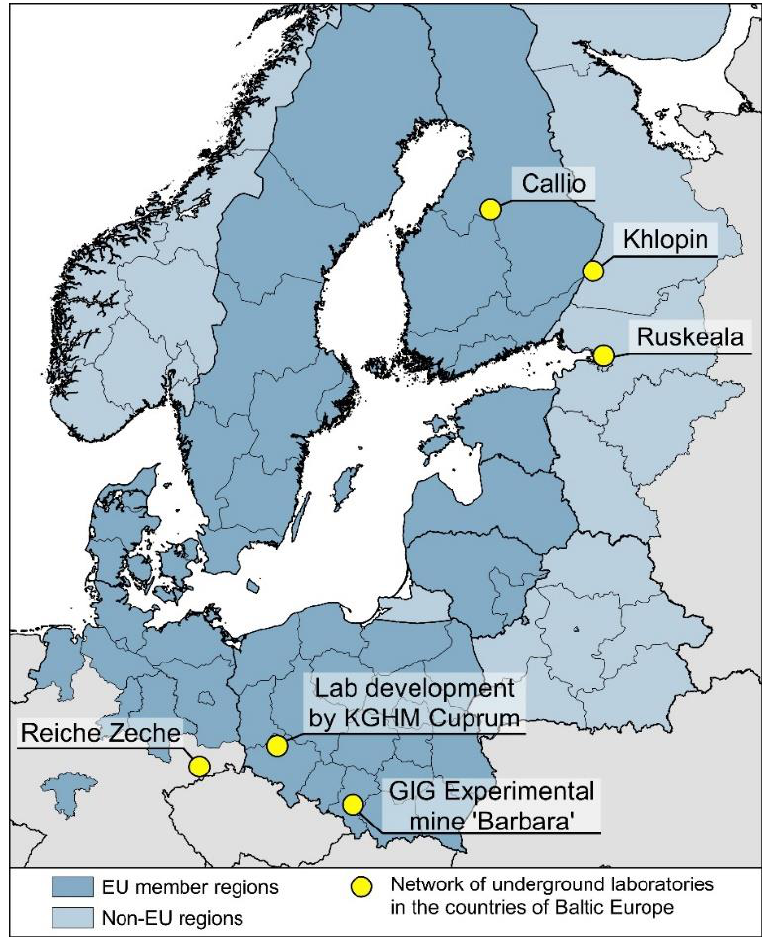
Figure 17. Network of underground laboratories. Source: own study based on [71].